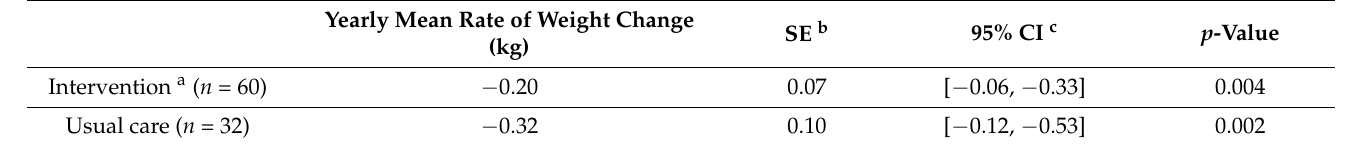
Table 2. Mean weight trajectories during the follow-up period by group.